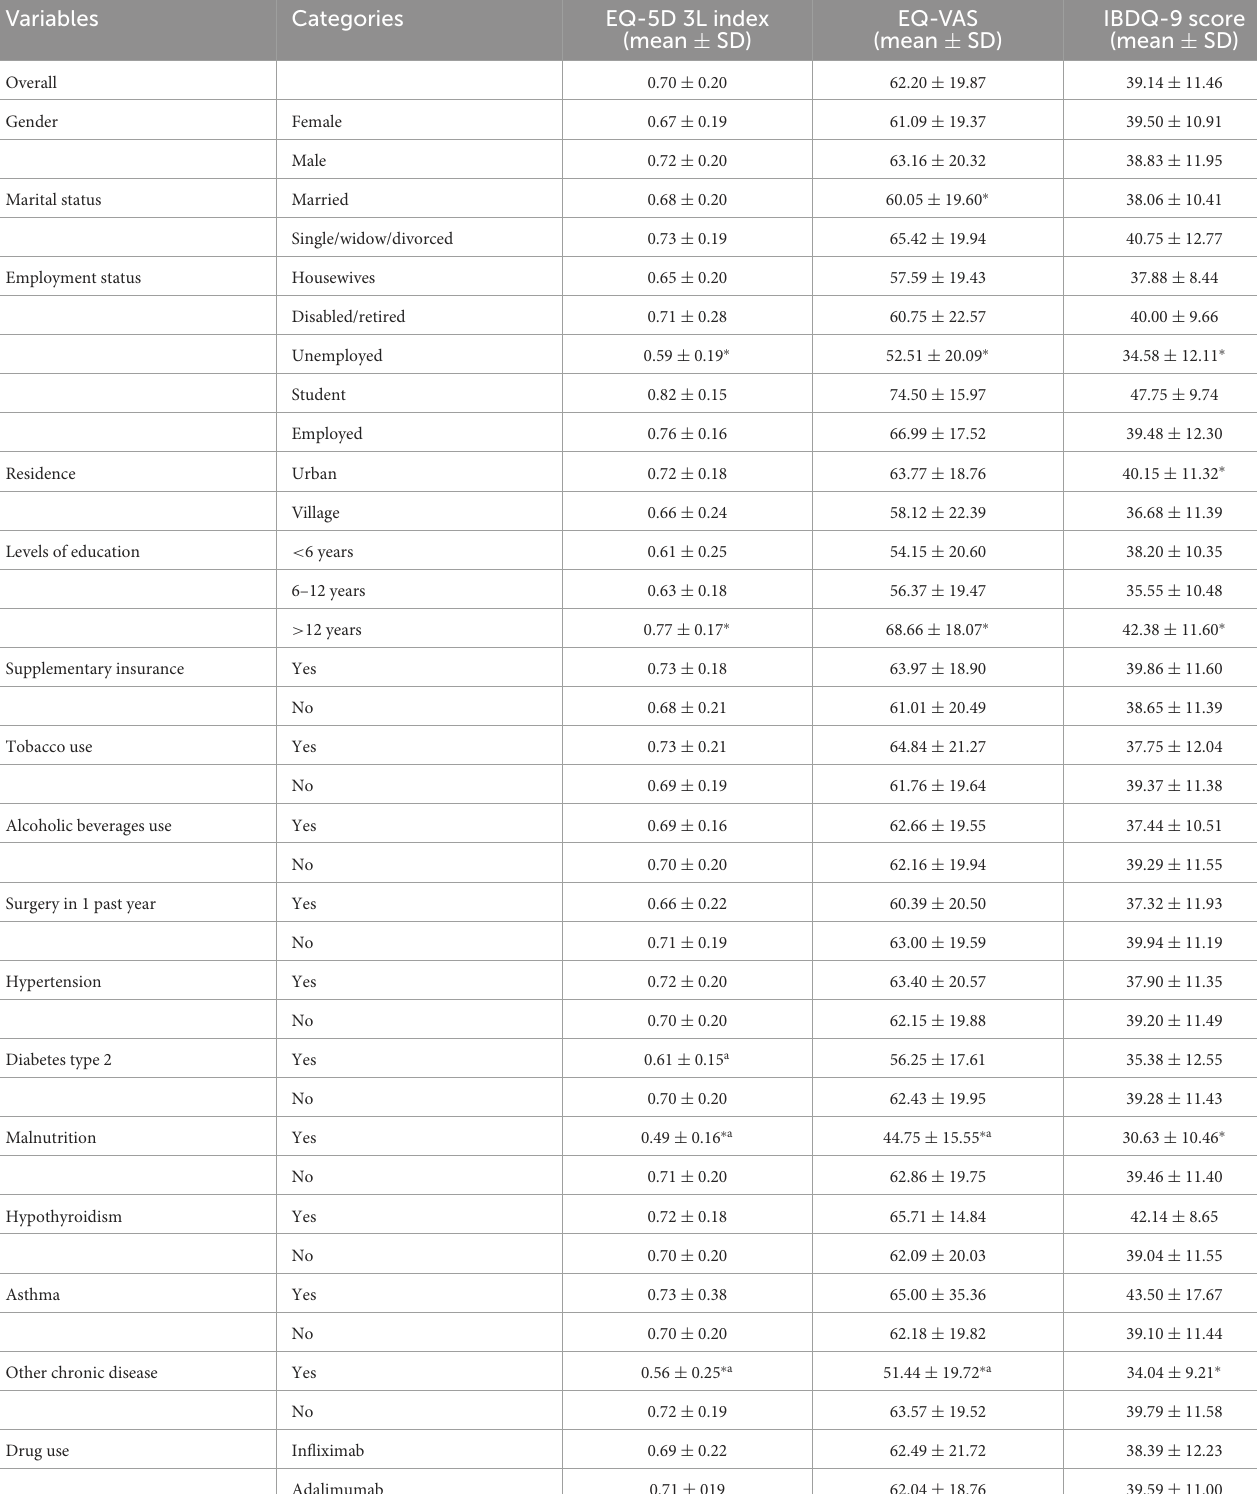
TABLE 3 Mean and standard deviation of EQ-5D index, IBDQ-9 Score and EQ-VAS stratified by socio-demographic and clinical